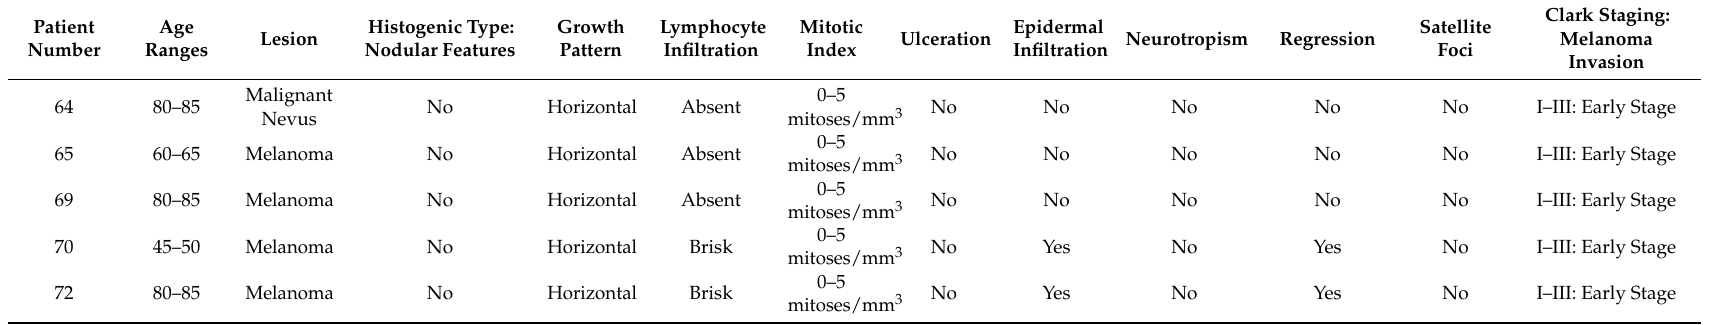
Table 3. Clinical and biological (tumor) characteristics of melanoma-affected Greek patients herein investigated. Patient number, age ranges, lesion, histogenic type, growth pattern, lymphocyte infiltration, mitotic index, ulceration, epidermal infiltration, neurotropism, regression, satellite foci, and Clark staging are shown. Patient